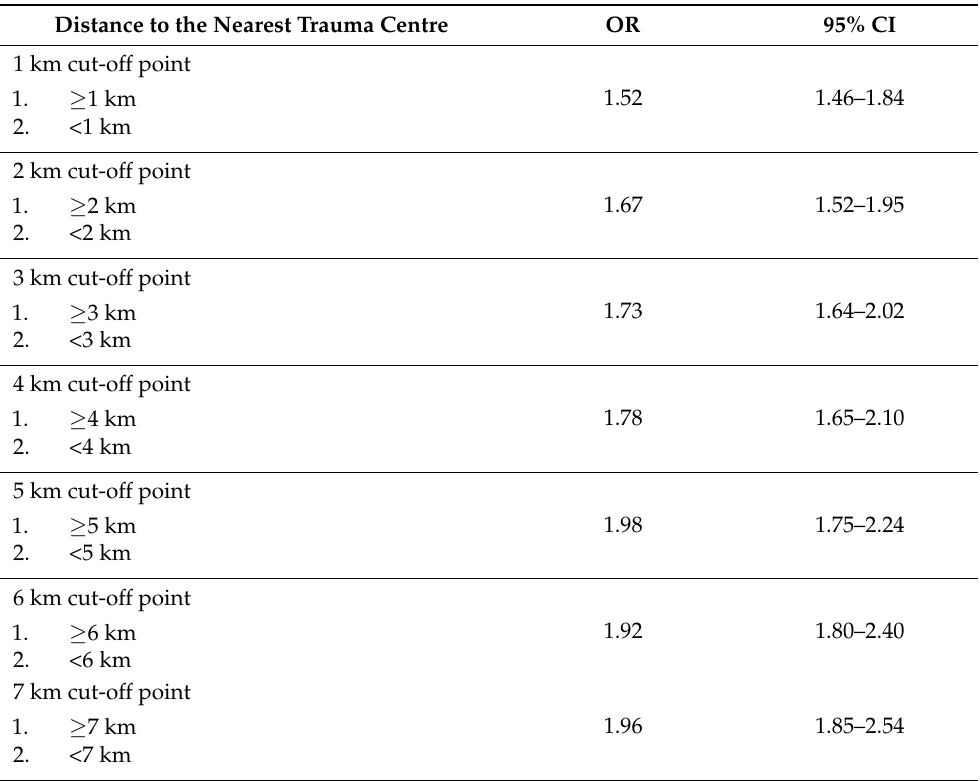
Table 1. Analysis of different cut-off points for distance to the nearest trauma centre. Distance to the Nearest Trauma Centre OR 95%